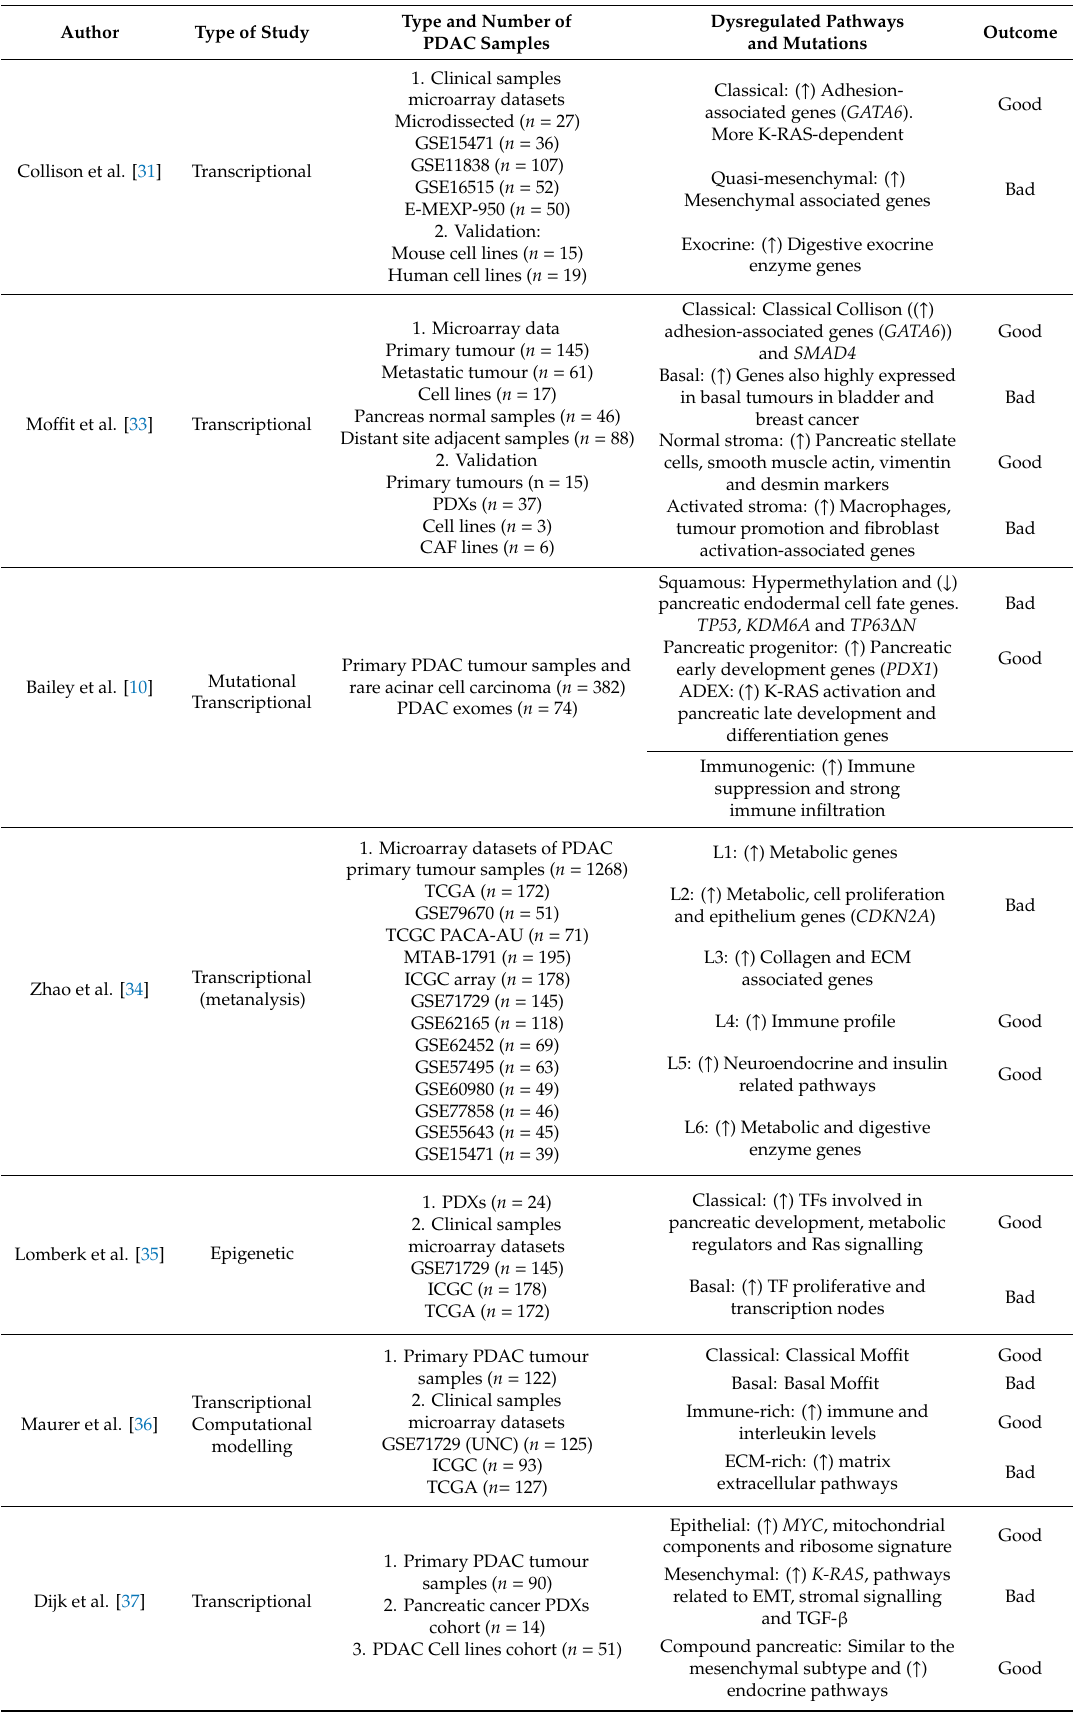
Table 1. Molecular Pancreatic Ductal Adenocarcinoma (PDAC)